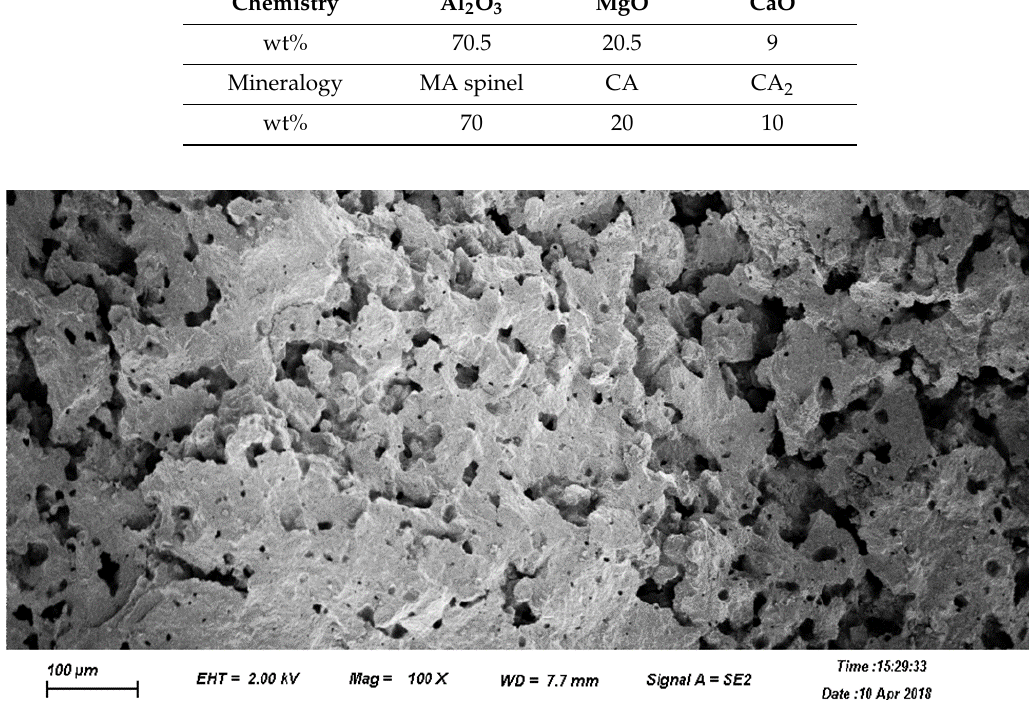
Figure 1. Microstructure of MagA aggregate.